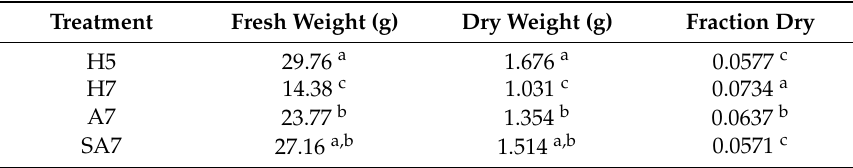
Table 5. Least squares mean analysis (LSM) of the combined data from both trials. Levels not connected by the same letter are statistically different by Tukey’s honest significant difference (HSD) ( alpha value =